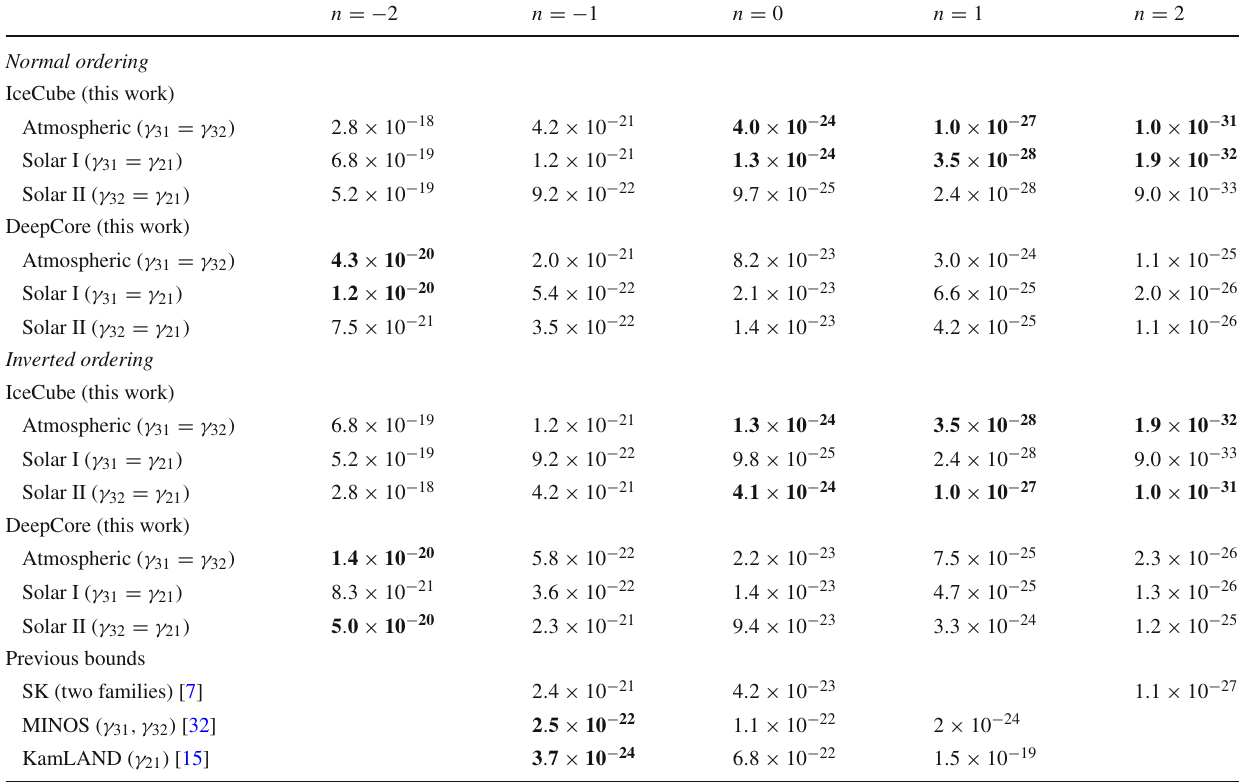
Table 3 DeepCore/IceCube bounds on γ 0 γ 0 ( E / GeV ) n ), at the 95% CL (1 degree of freedom), for both nor- ij mal and inverted ordering as indicated. Previous constraints are also